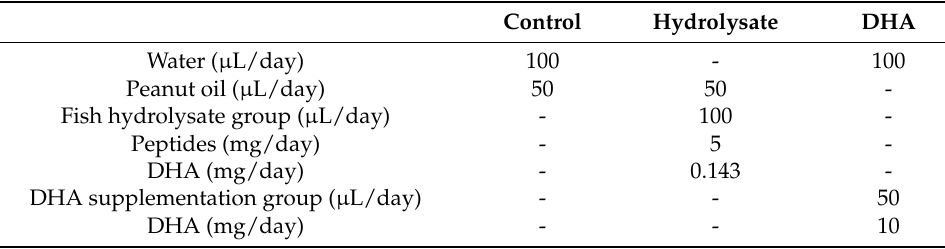
Table 1. Composition of the